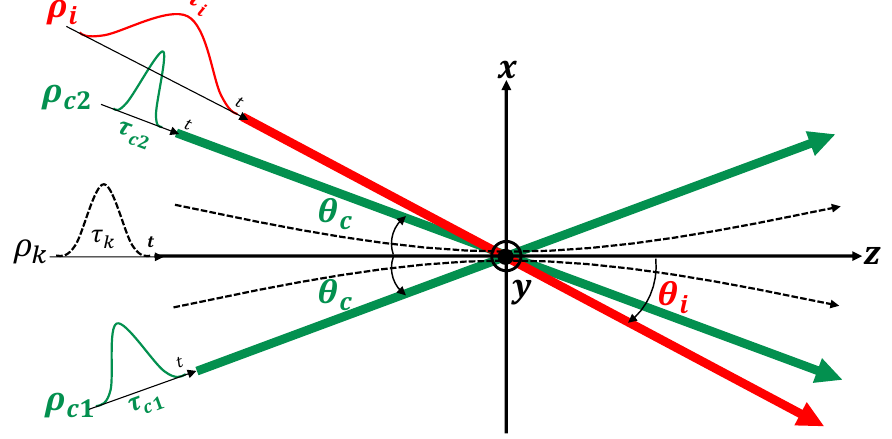
Figure 3. Collision geometry between three short pulsed laser beams to define the spacetime overlap- ping factor D three